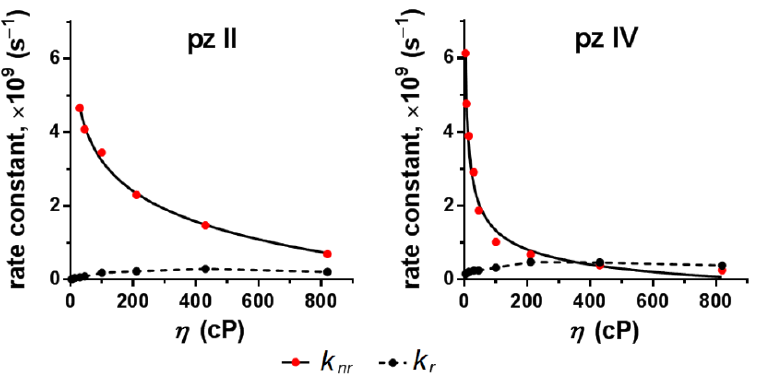
Figure 6. Dependence of constants of radiative ( k r ) and non-radiative ( k nr ) relaxation of pz II and pz IV on the viscosity.